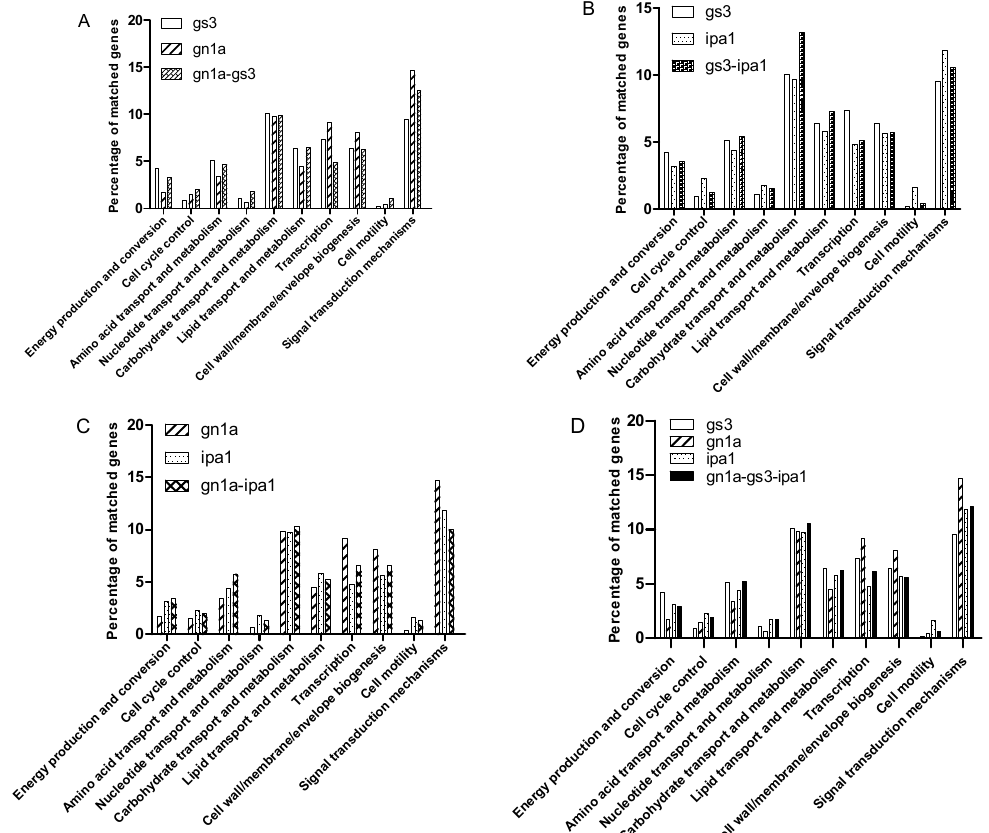
Figure 4. COG function classification of DEGs in different lines. ( A ) The COG function classification of DEGs in gs3 , gn1a and gs3-gn1a ; ( B ) The COG function classification of DEGs in gs3 , ipa1 and gs3-ipa1 ; ( C ) The COG function classification of DEGs in gn1a , ipa1 and gn1a-ipa1 ; ( D ) The COG function classification of DEGs in gs3 , gn1a , ipa1 and gn1a-gs3-ipa1 . Hormones play important roles in controlling plant growth and development and pyramided lines were found to alter the expression pattern of many hormone-related genes (Table S3). According to transcriptome data, we found at least 24 auxin-related genes to be differentially regulated. These genes were associated with indole-3-acetic acid- amido synthetase, auxin-induced SAUR-like protein, auxin-responsive protein, auxin response factor, auxin efflux carrier, auxin transport, and others. Ten cytokinin-related genes belong to cytokinin-O-glucosyltransferase, tRNA isopentenyltransferase, cytokinin dehydrogenase, cytokinin riboside 5 ′ -monophosphate phosphoribohydrolase, and others, respectively. In addition, three gibberellin-related genes, five brassinosteroid-related genes and one strigolactone-related gene were also identified. Comparison of gene expression in different lines showed that many of the DEGs in single mutant did not